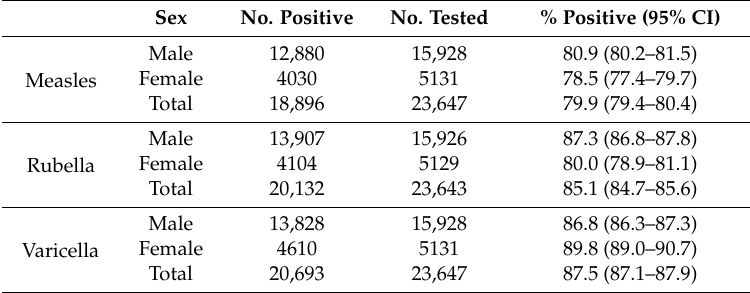
Table 2. Number of positive and tested samples and seroprevalence with 95% confidence intervals for measles, rubella and varicella antibodies.